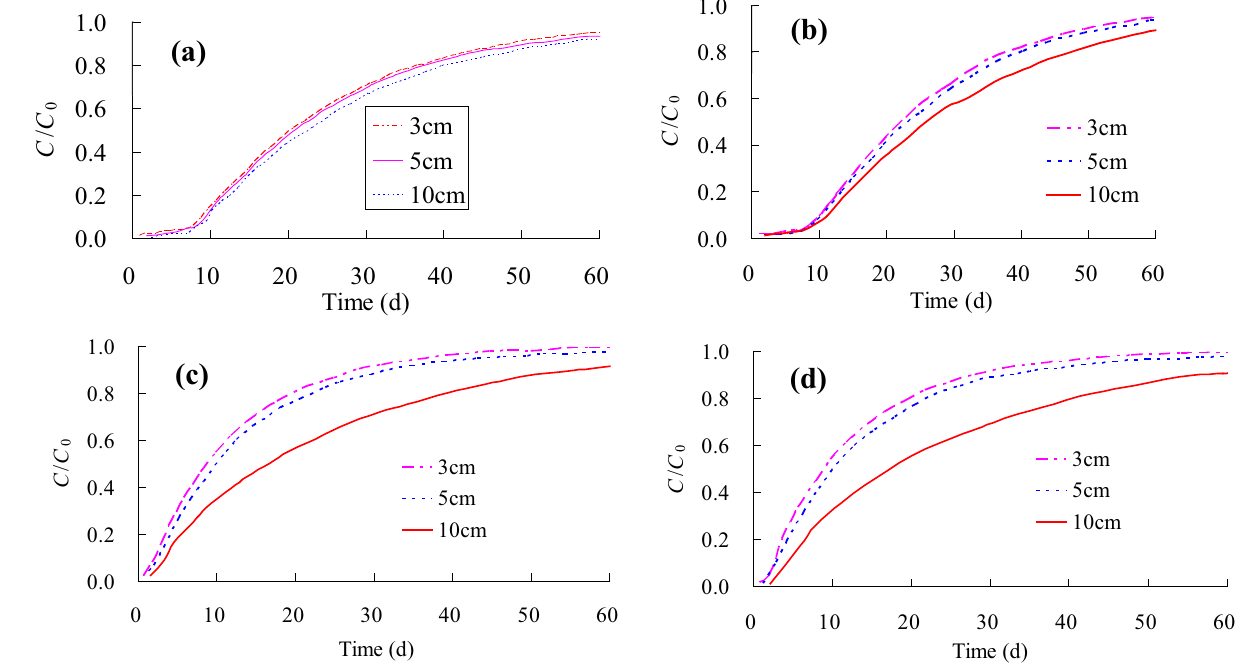
Figure 6. Concentration breakthrough curves for different thicknesses of the non-penetrating zone: ( a ) Obs1, ( b ) Obs2, ( c ) Obs3, ( d ) Obs4.